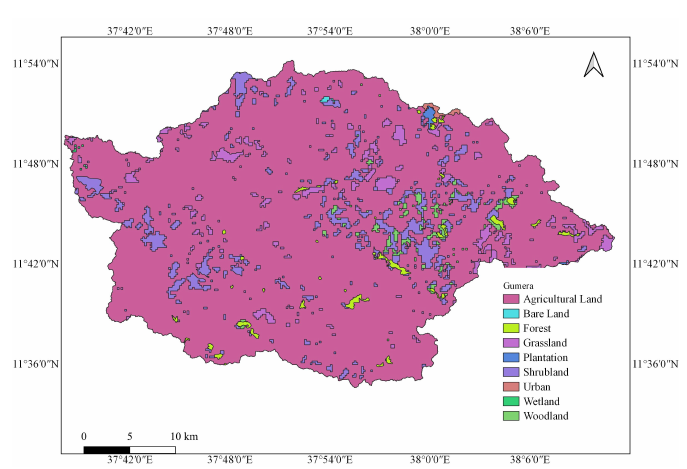
Figure 13. Land use map of the Gumera Watershed from 1989 to 2009.